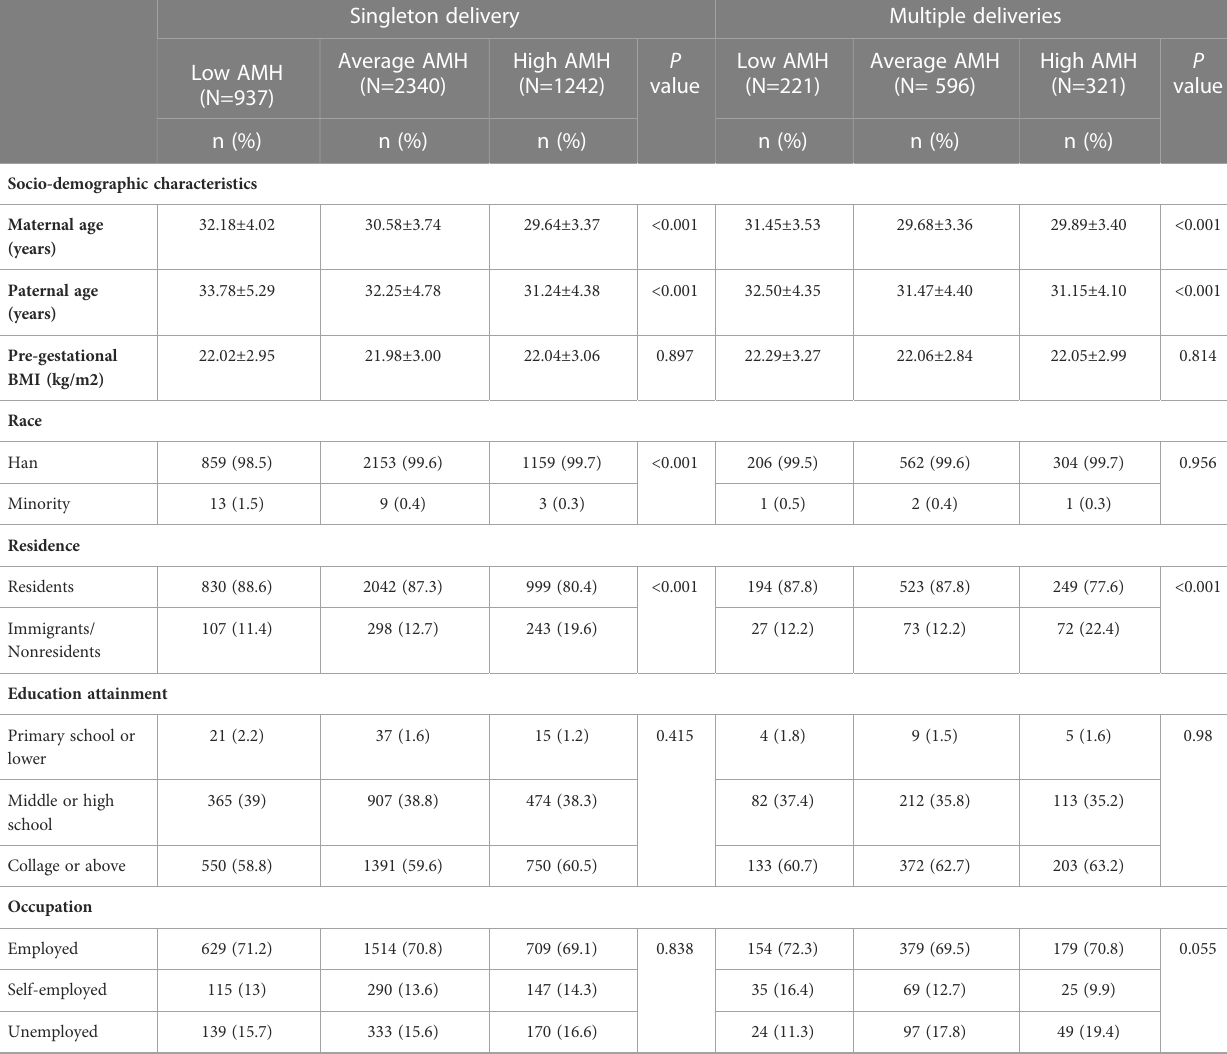
TABLE 1 Baseline characteristics of participants with live birth deliveries according to AMH